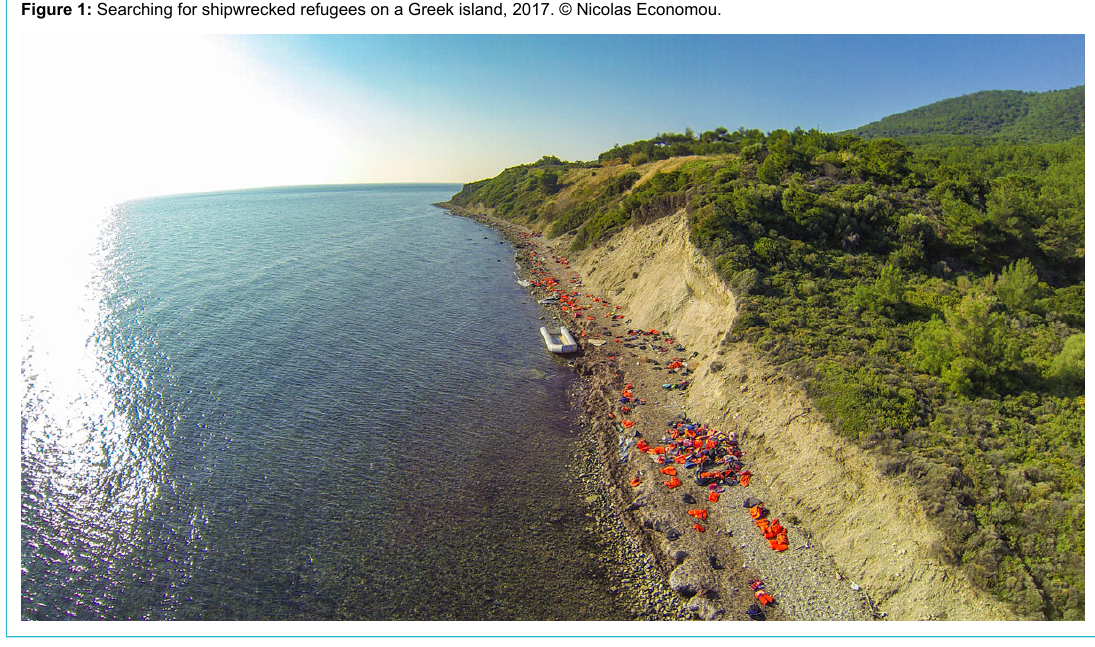
Figure 1: Searching for shipwrecked refugees on a Greek island, 2017. © Nicolas Economou.